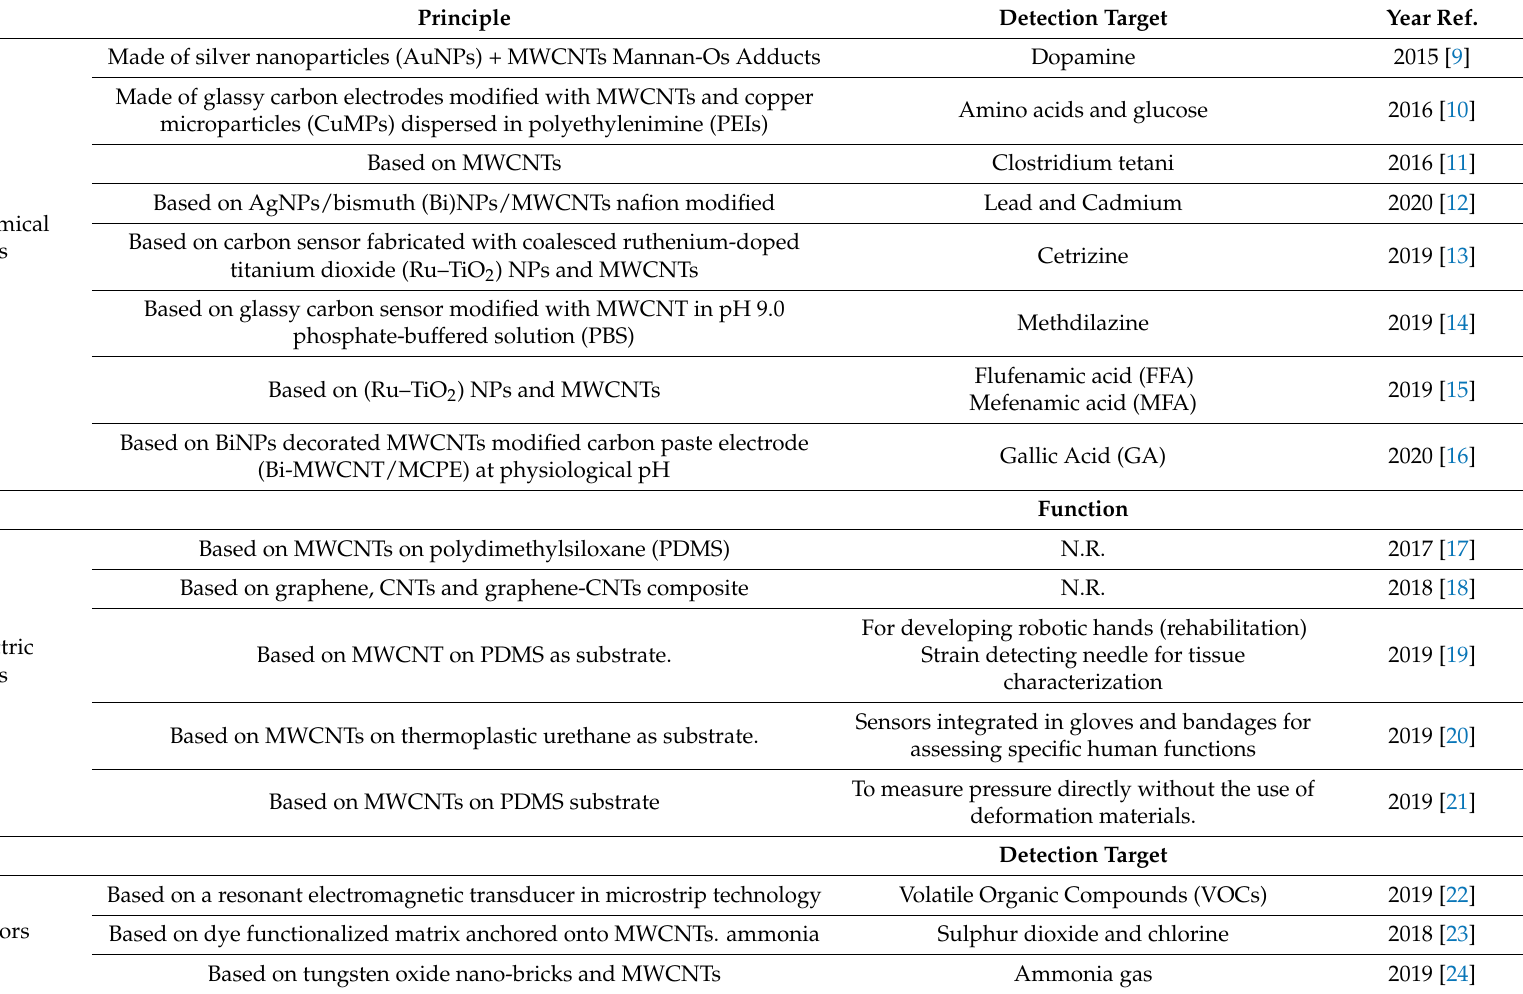
Table 1. Main biomedical application of